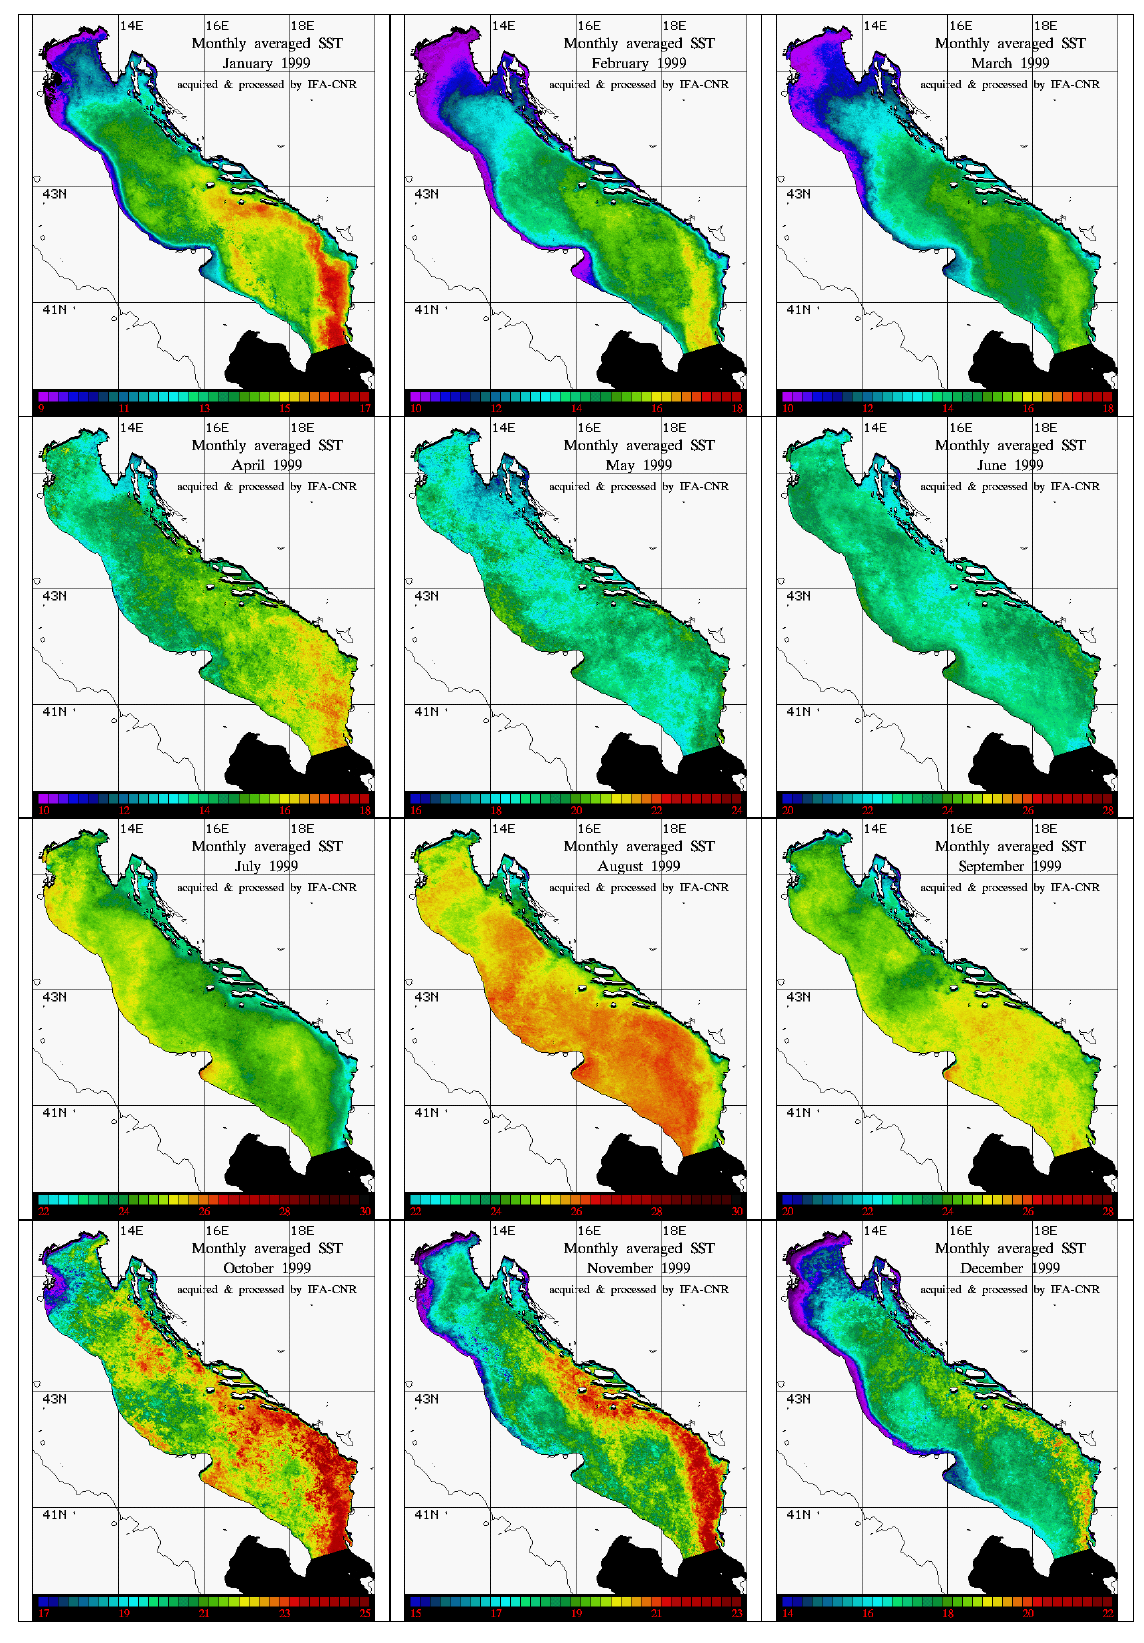
Fig. 2a. Monthly median SST fields for the January – December 1999